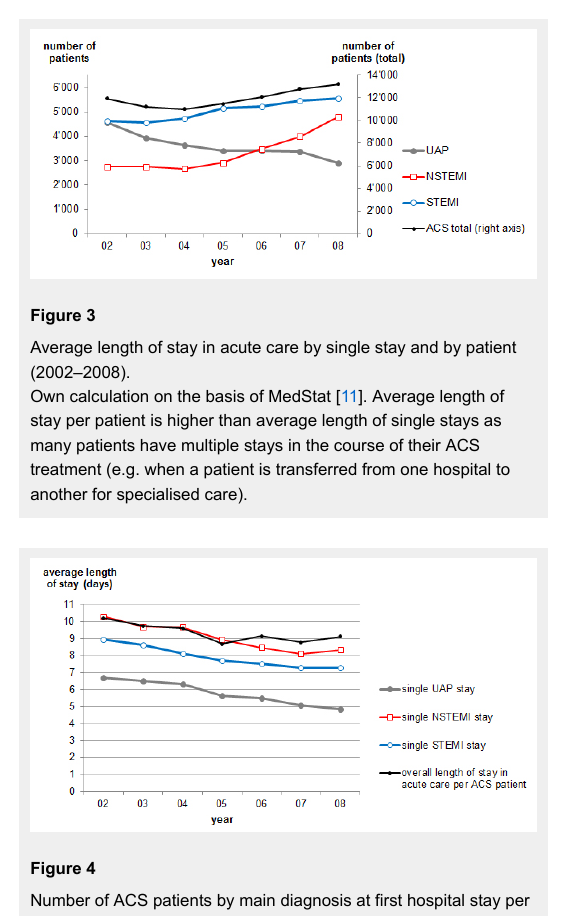
Number of ACS patients by main diagnosis at first hospital stay per year (2002–2008). Own calculation on the basis of MedStat [11].